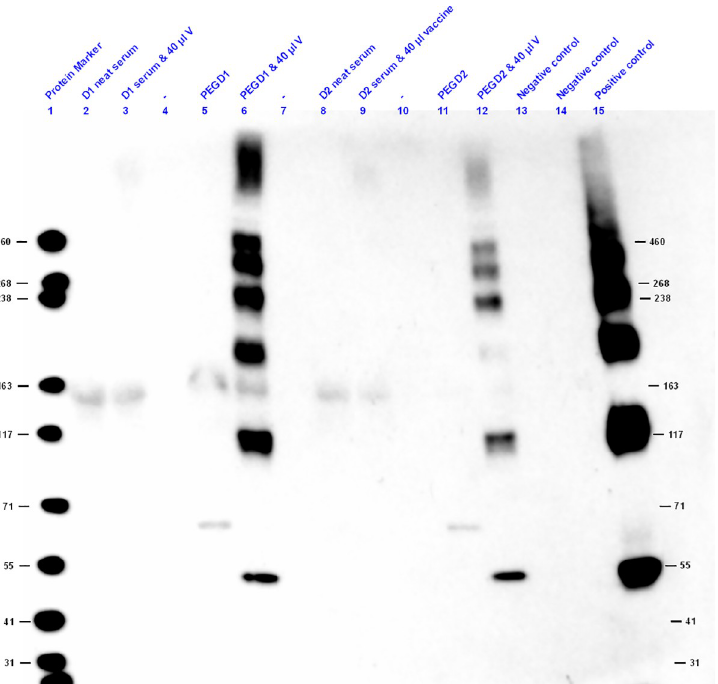
Fig 4. H1N1 Western blotting of healthy adult serum and serum spiked with vaccine, PEG precipitates from two healthy adult donor samples showed that influenza antigen was only detected in the PEG precipitated serum samples spiked with vaccine. Lane 1 of the gel is the Precision Plus protein standard ranging from 31 to 460 kDa. Three μ g of protein per lane was loaded on a 3–8% Tris-acetate denaturing SDS-PAGE gel, blotted to nitrocellulose membrane and incubated with rabbit anti-H1N1 influenza A virus (primary antibody), goat anti-rabbit immunoglobulin HRP (secondary antibody) and stained using the ECL kit. D stands for Donor, V for vaccine. Negative control (Lane 13) is PEG with H 2 0 and 40 ul of vaccine and negative control (Lane 14) is PEG with PBS.